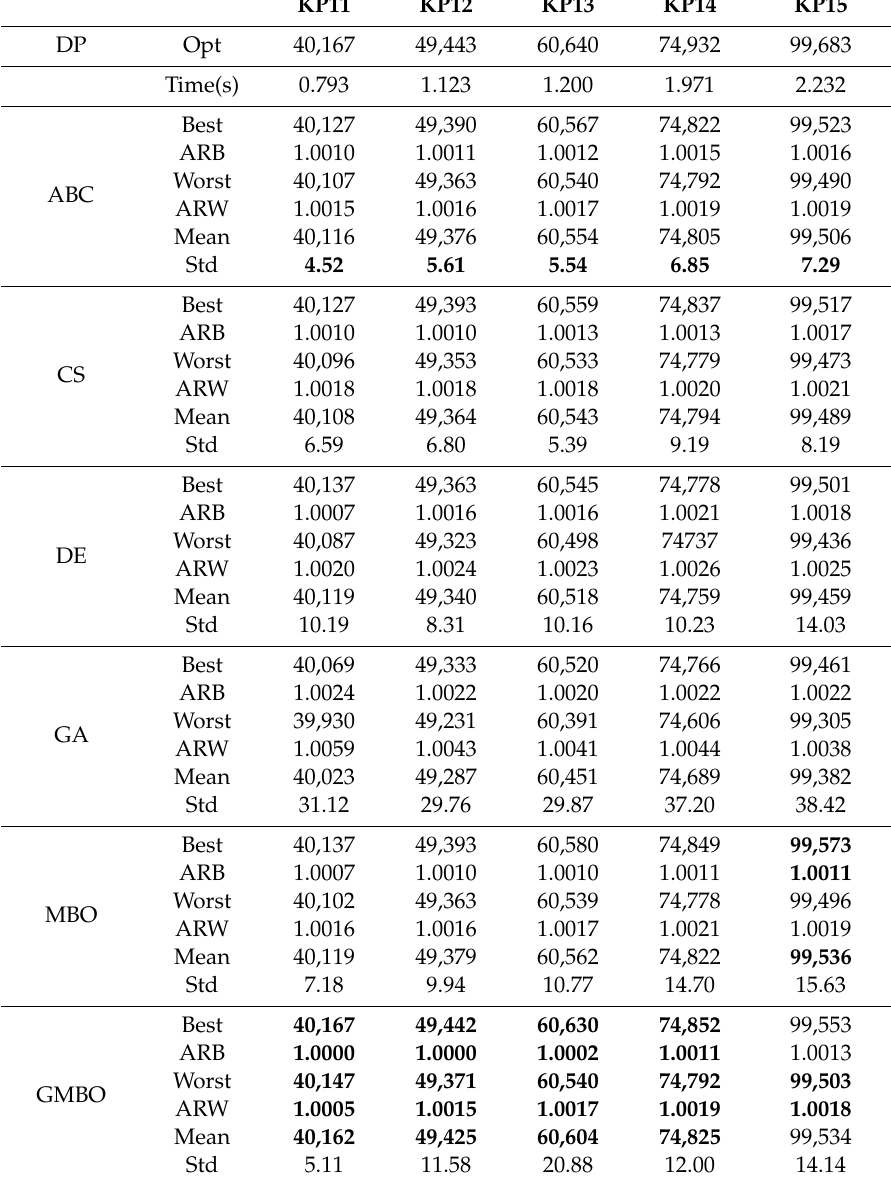
Table 10. Performance comparison of large-scale five strongly correlated 0-1KP